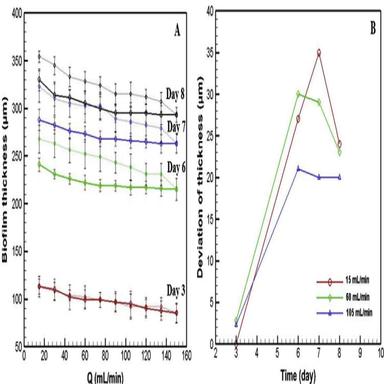
Variation of biomass thickness as a function of the feed flow rate during compression (solid line, red error bars) and decompression (dotted line, black error bars) processes at different days of filtration (A), and deviation of thickness between the compression and decompression of biofilm over time at Q = 15, 60 and 105 mL/min (B). (For interpretation of the references to color in this figure legend, the reader is referred to the Web version of this article.)